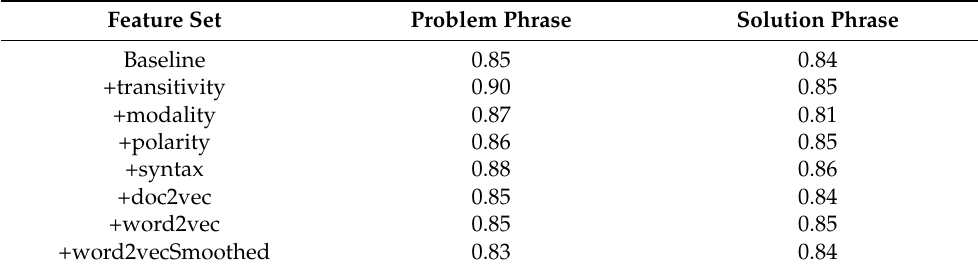
Table 9. Hyperparameter tuning the CNN model for the data iteration method.